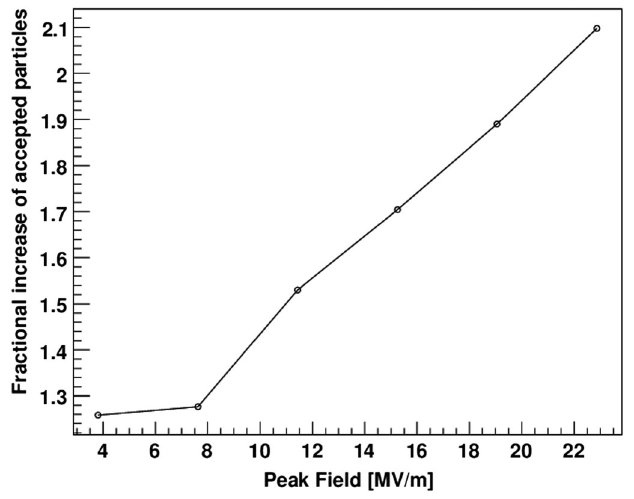
FIG. 6. The degradation in cooling performance with de- creased rf voltage is shown. The baseline cooling lattice was simulated with lithium hydride thickness proportional to rf peak voltage to account for the reduction in energy gain and the number of muons within the accelerator acceptance was calcu- lated before and after the cooling channel. The ratio of these two values was plotted against cooling channel rf field for a number of peak fields. The nominal cooling channel rf voltage is 16 MV = m .